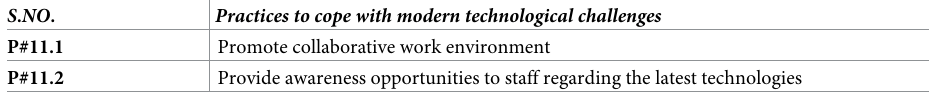
Table 14. Practices to cope with modern technological challenges in